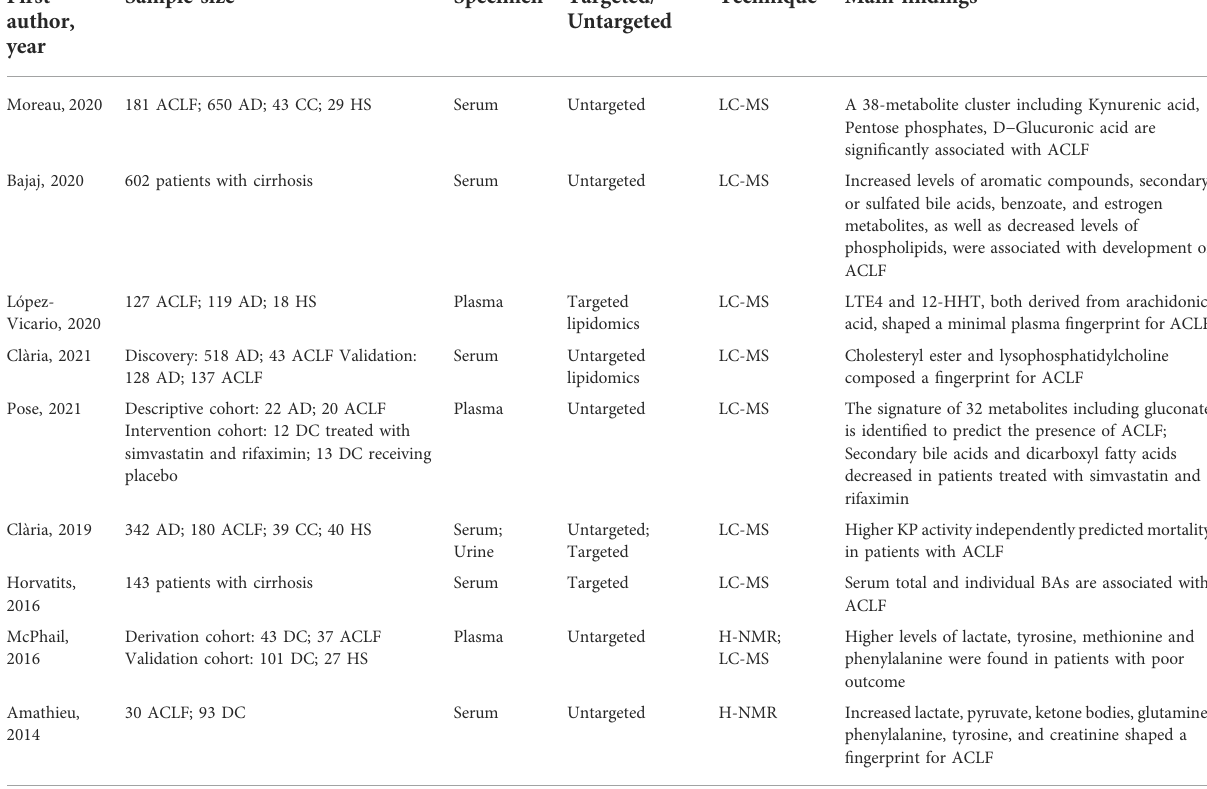
TABLE 1 Biomarkers associated with ACLF from the clinical studies of